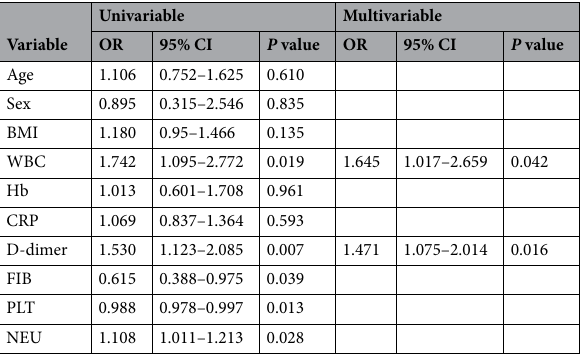
Table 4. Predictors of in-hospital mortality in patients with type A AAD by logistic regression. BMI, body mass index; WBC, white blood cells; Hb, hemoglobin; CRP, C reactive protein; FIB, fibrinogen; PLT, platelet; NEU,